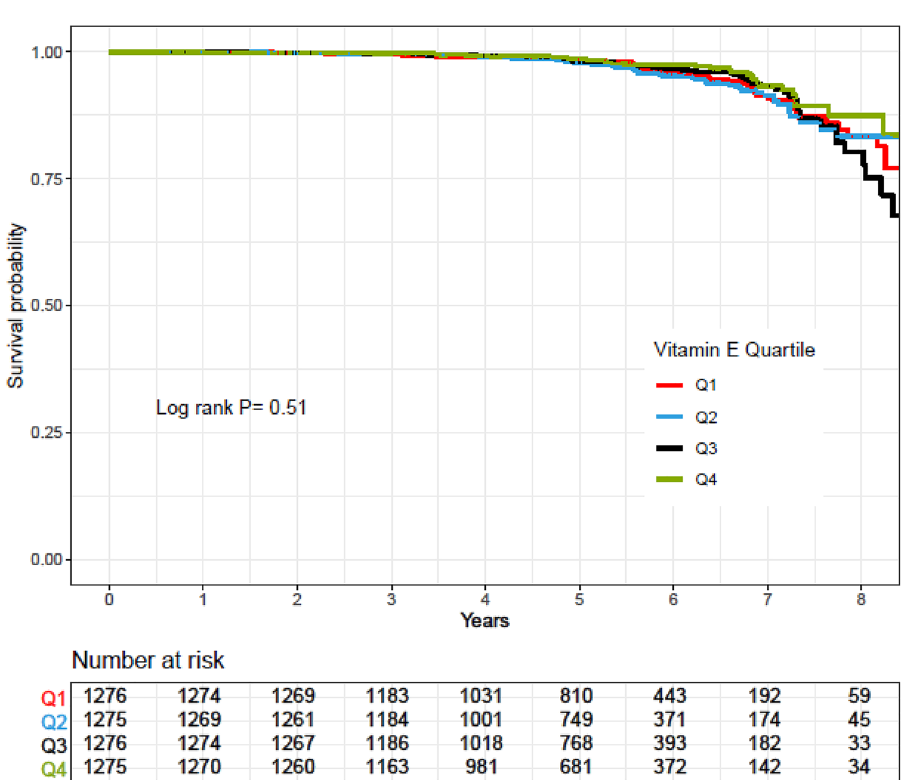
Figure 2. Kaplan–Meier estimates of CVD-free survival according to quartiles of vitamin E intake. P values by log-rank test and number of CVD outcomes recorded in the groups categorized by vitamin E